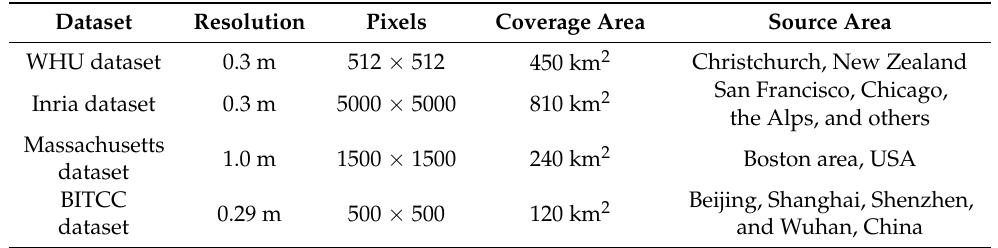
Table 1. Details of each dataset.